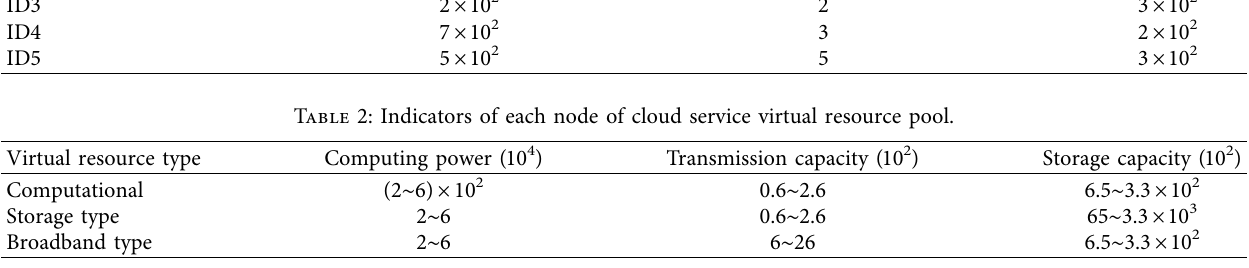
Table 3: Indicators required by cloud users to perform system tasks (MB).